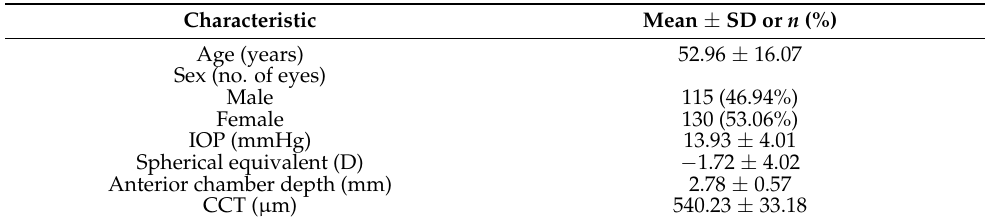
Table 1. Baseline clinical